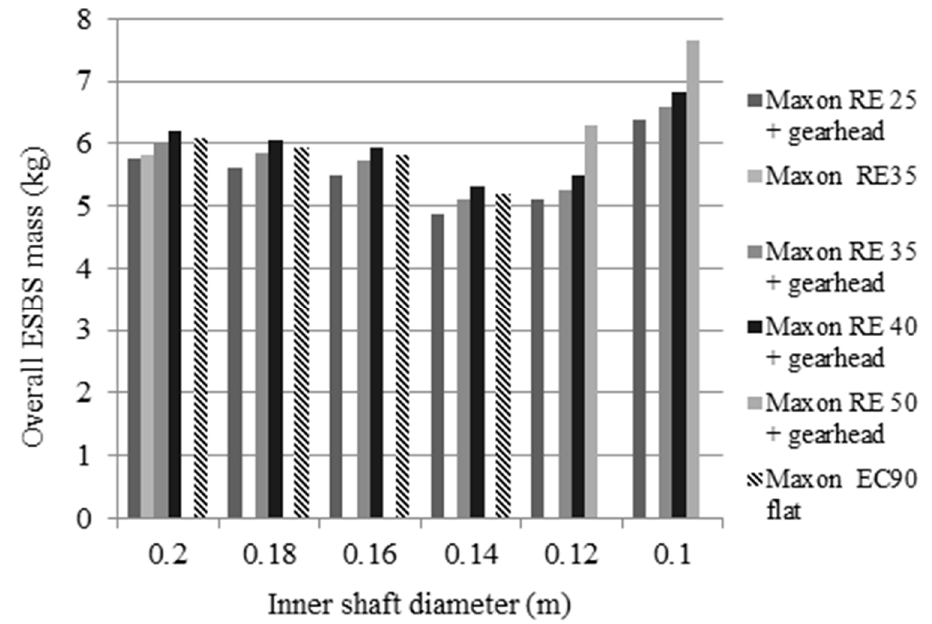
Figure 15. Estimated total mass of the inline threaded clamp arrangement.